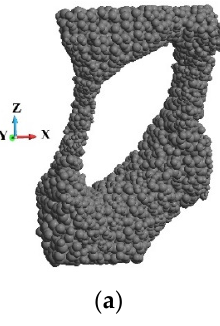
Figure 19. The enhanced details of the foam microstructures: ( a ) region o1; ( b ) region o2; ( c ) region o3.